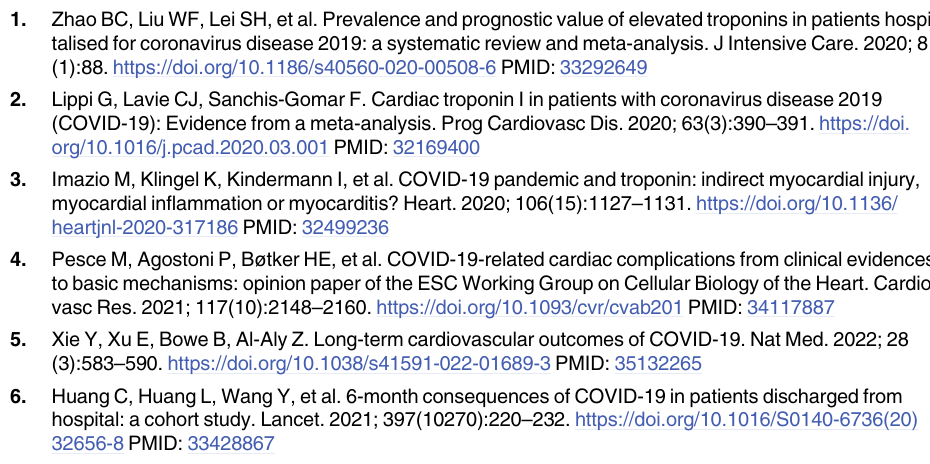
S1 Protocol. Original study protocol written in Finnish. S2 Protocol. Original study protocol translated to